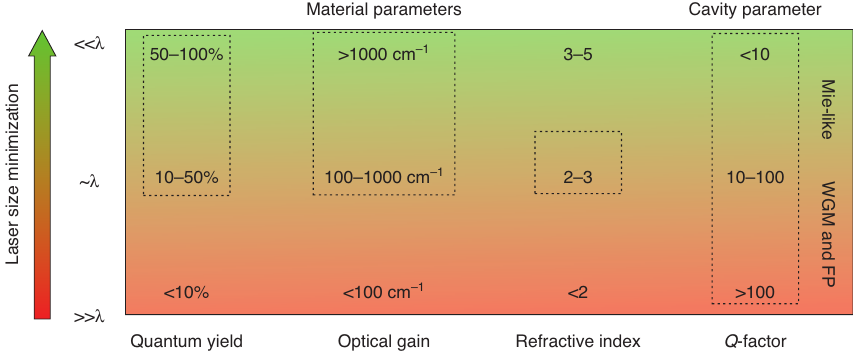
Figure 2: Scheme for the most important parameters for laser size minimization. Dashed lines indicate ranges of values typical for bulk halide perovskites.